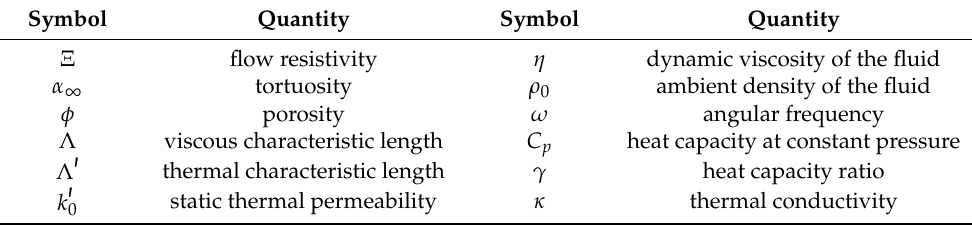
Table A3. Symbols used in the JCAL